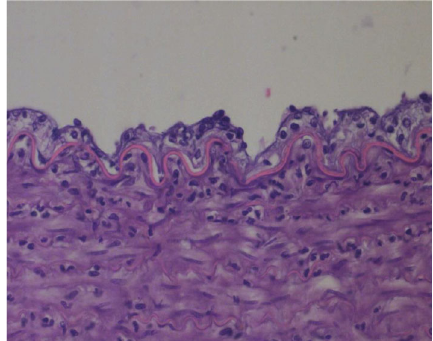
Figure 9: Pathological section of the right common carotid artery in the second experimental